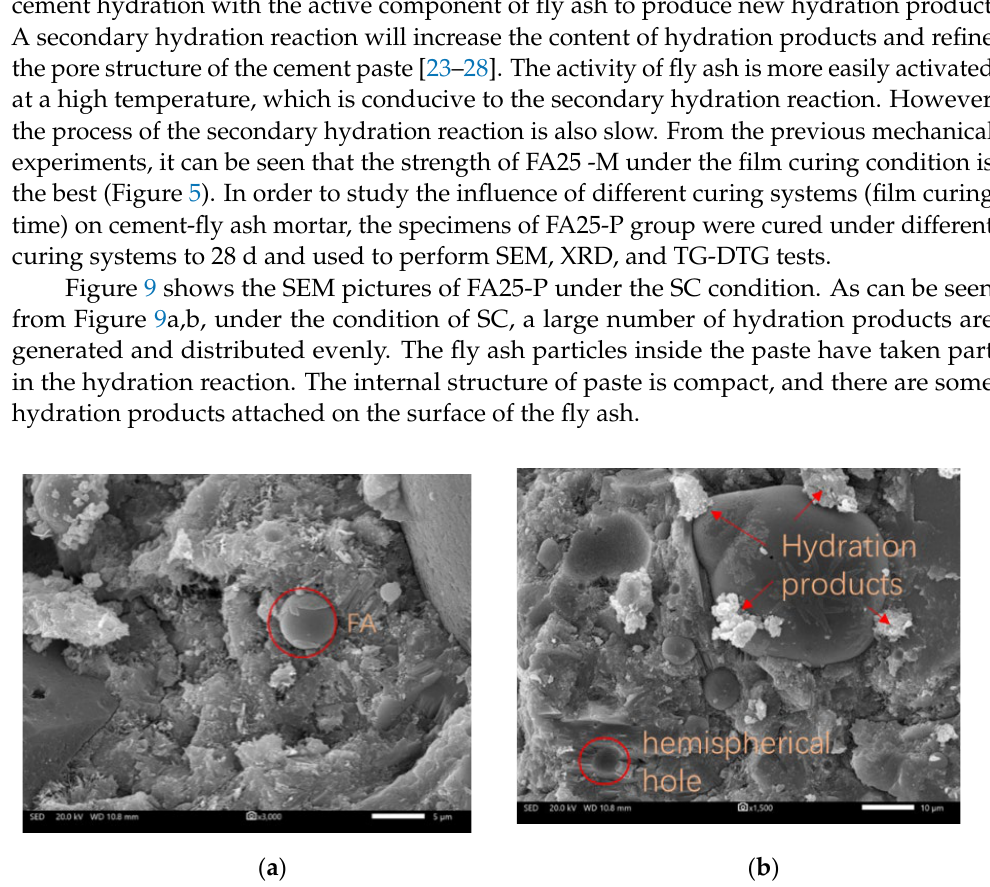
( b ) Figure 10. SEM pictures of FA25-P under HD condition, ( a ) Microstructure and ( b ) FA particles in paste. Figures 11–13 respectively show the SEM pictures of FA25-P under FC1–FC3 condi- tions. By comparing Figures 11–13, it can be seen that the microstructure of paste under the FC1 condition is compacter than HD, but there are still many pores, and the irregular